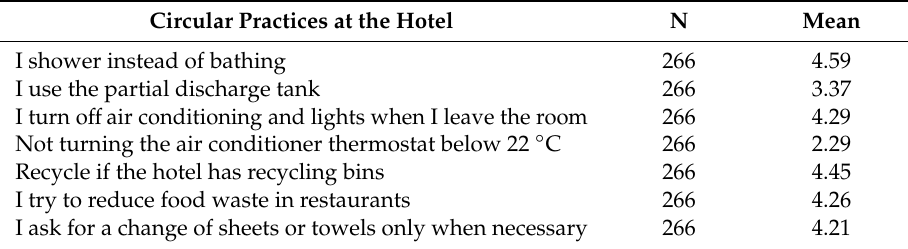
Table 11. Circular practices carried out by tourists at the hotel.